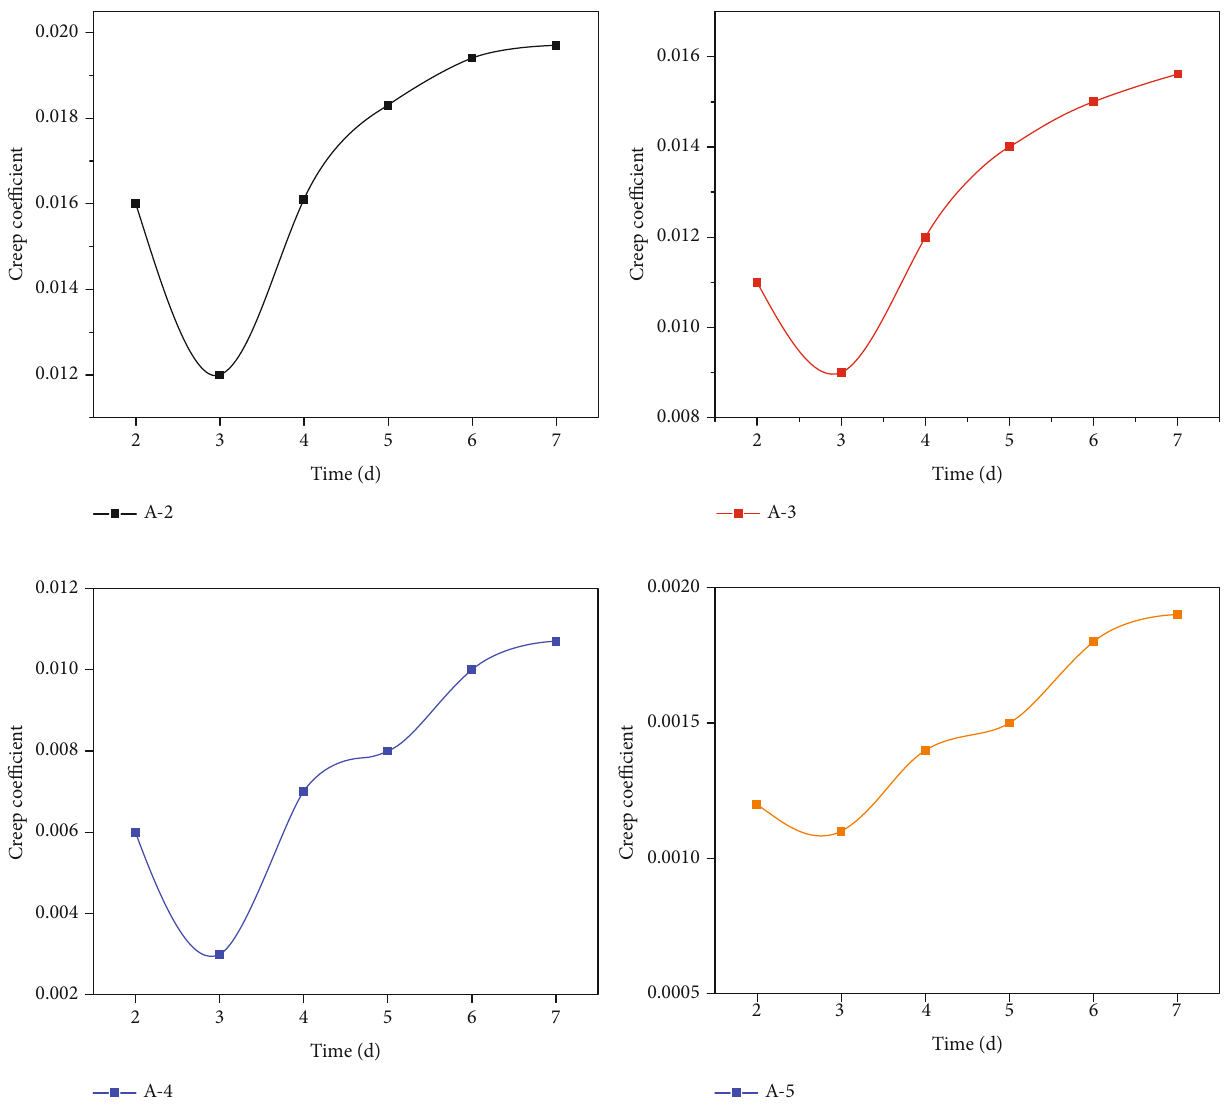
Figure 7: The relationship between creep coe ffi cients and